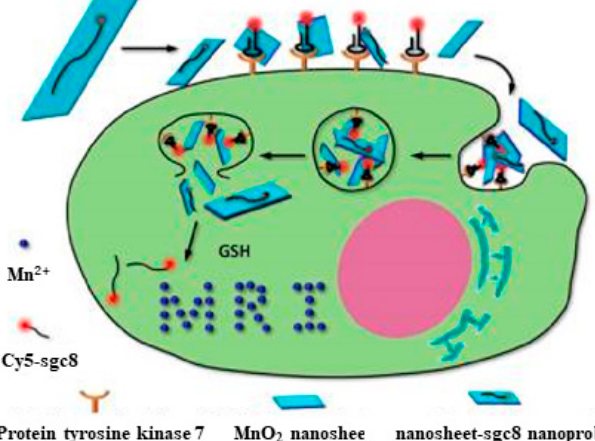
Figure 4. Activation mechanism of the MnO 2 nanosheet-aptamer nanoprobe for fluorescence/MRI bimodal tumor cell imaging. Reprinted with permission from © (2014) American Chemical Society [42].